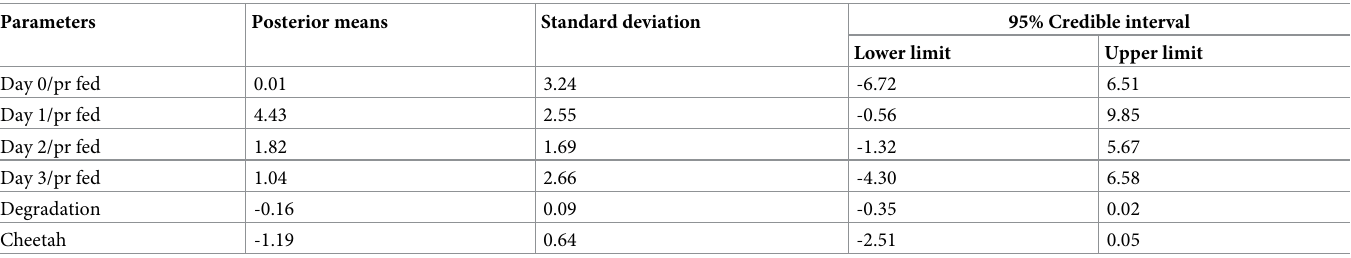
Table 3. Posterior summary of the